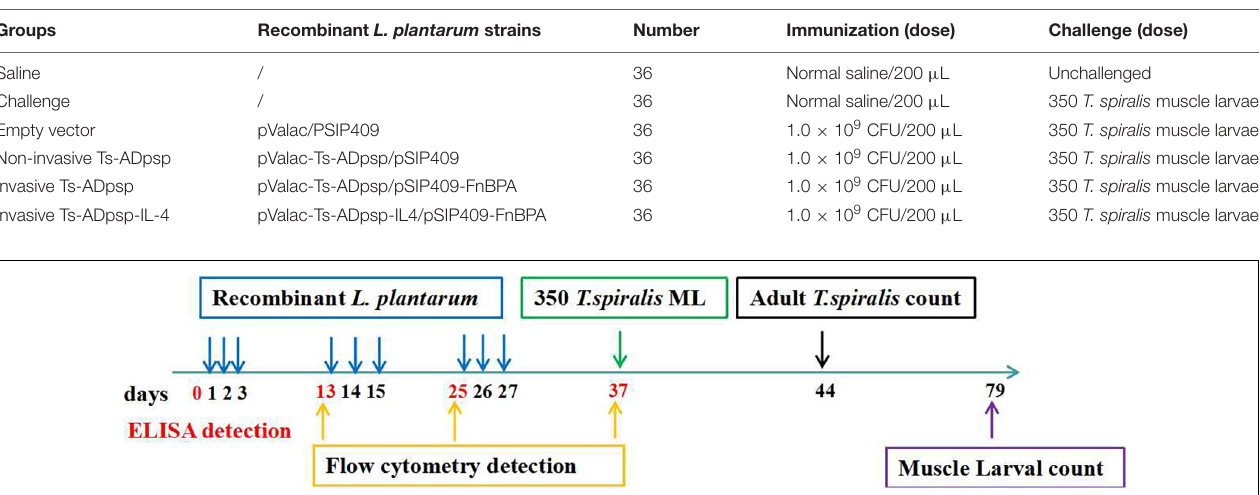
TABLE 1 | Immunization schedule and challenge doses.